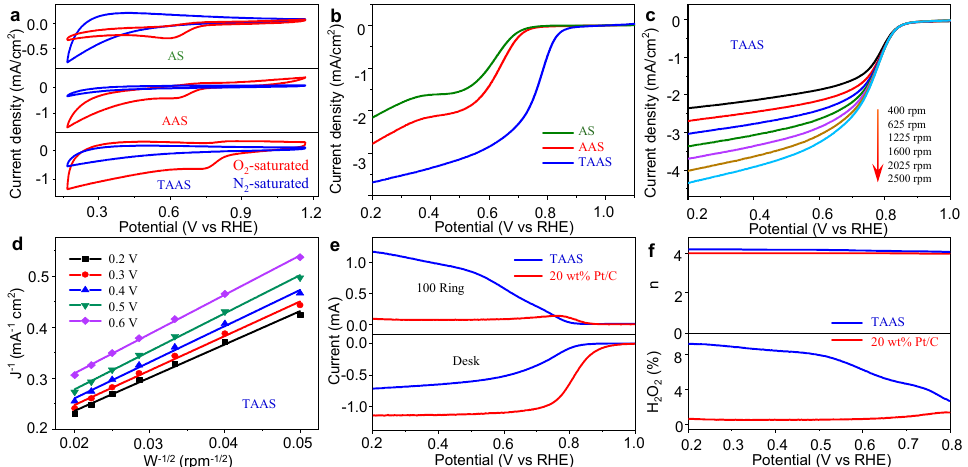
Figure 4. CV curves ( a ) of all catalysts in O 2 or N 2 -saturated 0.1 M KOH solution at room temperature and the scanning rate of 50 mV/s. The LSV curves of AS, AAS and TAAS at the electrode rotation rate of 1600 rpm and the scanning rate of 10 mV/s ( b ). The LSV curve ( c ) of TAAS at different speeds from 400 to 2500 rpm coincide with the K-L diagram ( d ) of TAAS from 0.2 to 0.6 V. The RRDE linear sweep voltammogram of TAAS and 20 wt% Pt/C in O 2 -saturated 0.1 M KOH at the electrode rotation rate and the scanning rate are 1600 rpm and 5 mV/s, respectively ( e ). Electron transfer number n ( up ) and H 2 O 2 yield ( down ) calculated from the RRDE measurement results of TAAS and 20 wt% Pt/C ( f ).